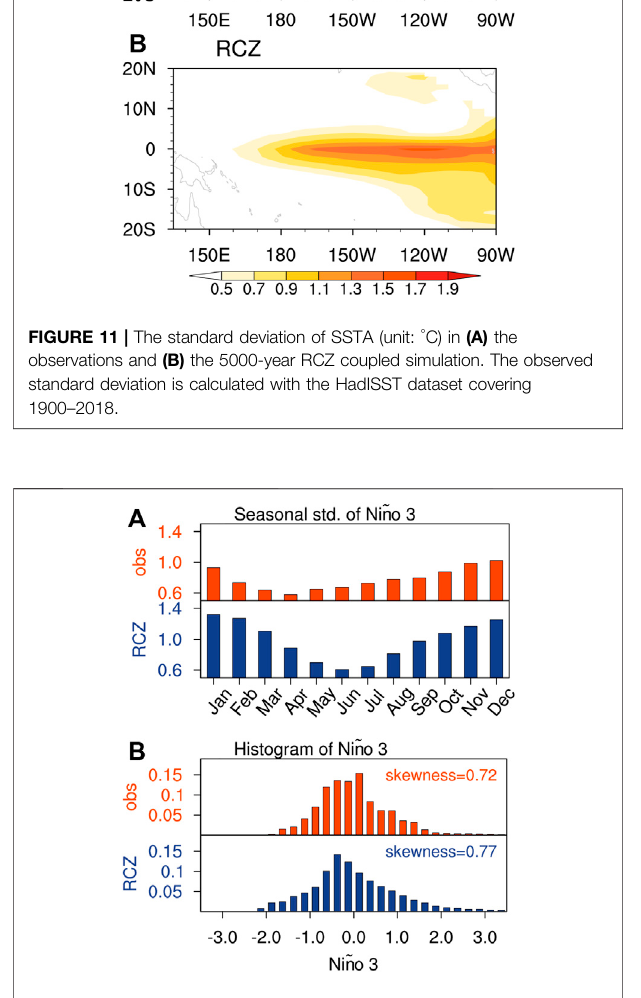
FIGURE12|(A) Seasonalstandarddeviation ofNiño3index (unit: ° C) in the observations (upper panel; red bars) and the RCZ simulation (lower panel; blue bars). (B) Histogram of the monthly Niño 3 index (unit: ° C) in the observations (upper panel; red bars) and the RCZ simulation (lower panel; blue bars). The bin size is 0.2 ° C.